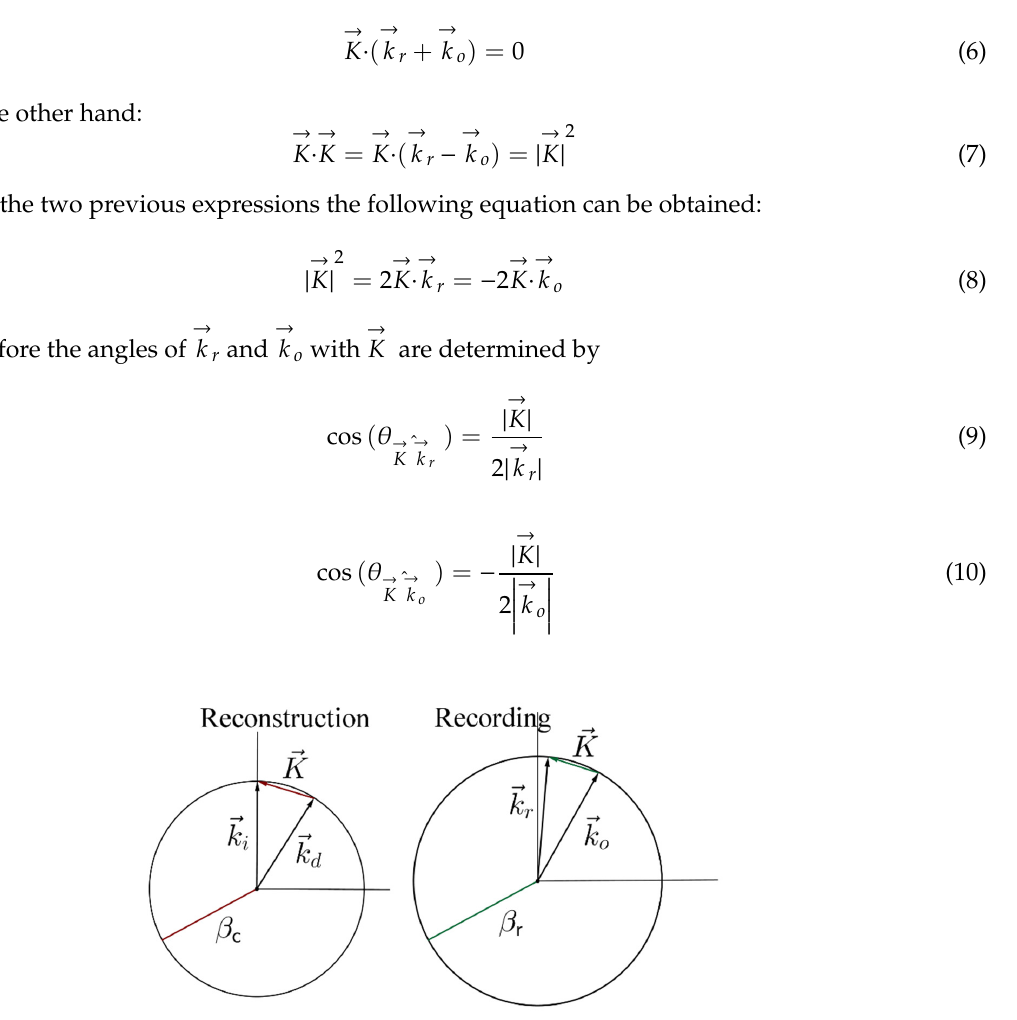
Figure 3. Recording and reconstruction geometry.